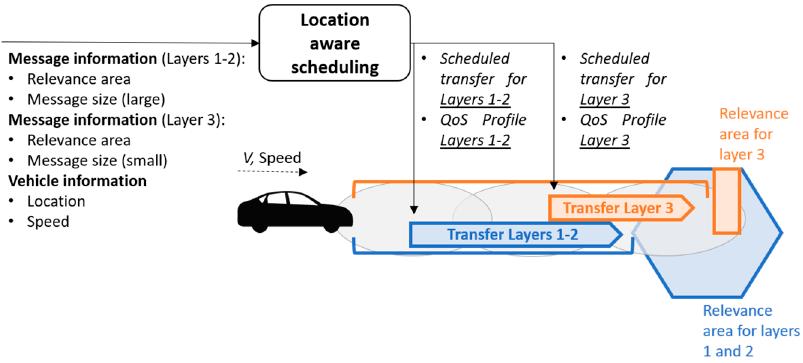
Figure 8. Example of the utilization of location-aware scheduling applied to high definition (HD) map acquisition use case.